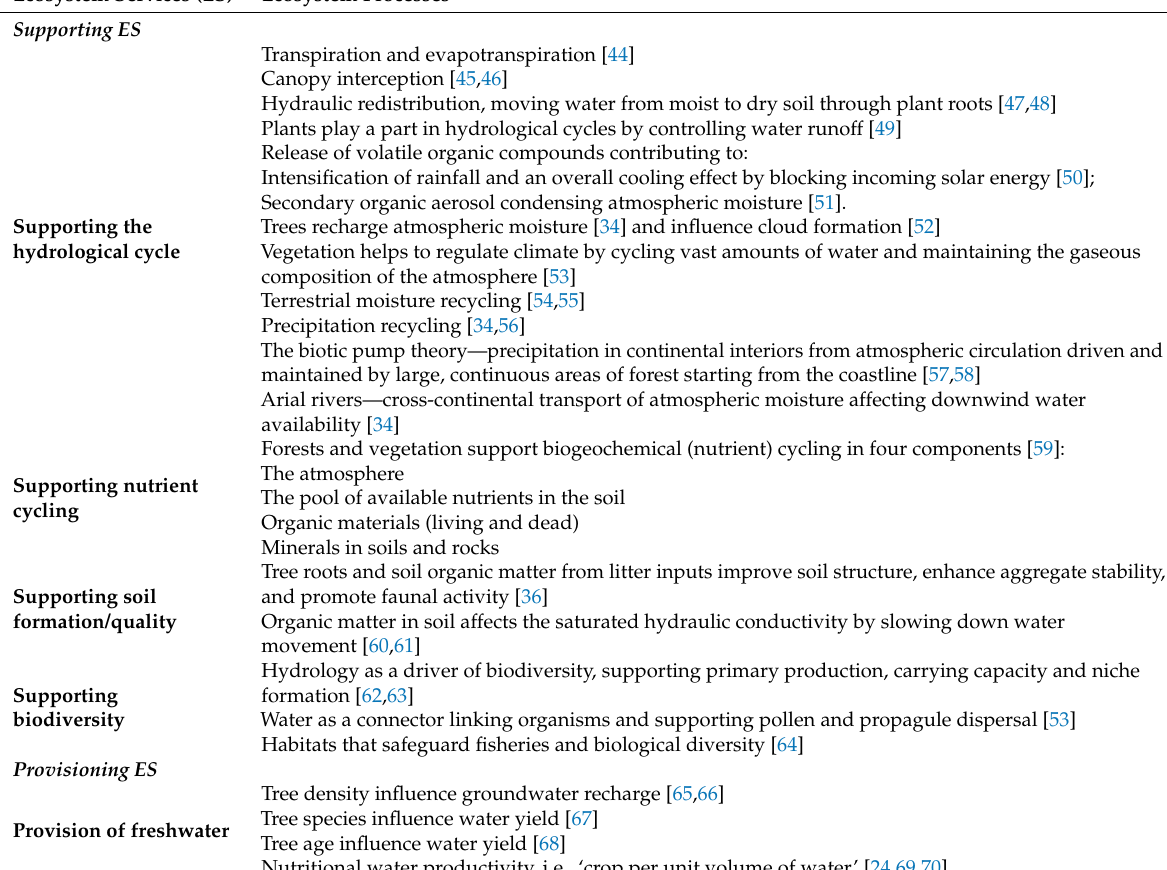
Table 2. Synthesis of water-related ecosystem